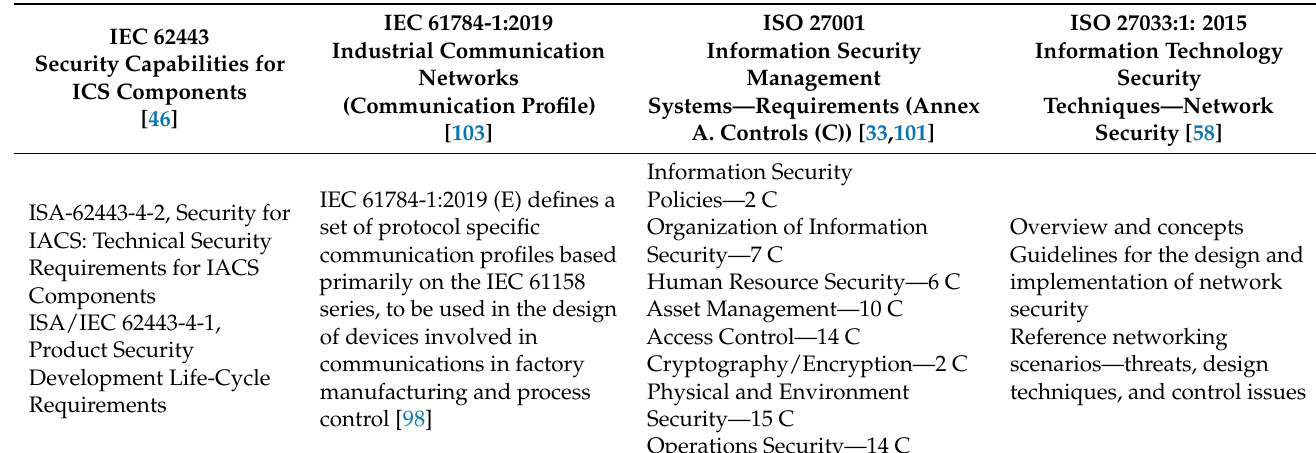
Table 5. IIoT communication and security standards.